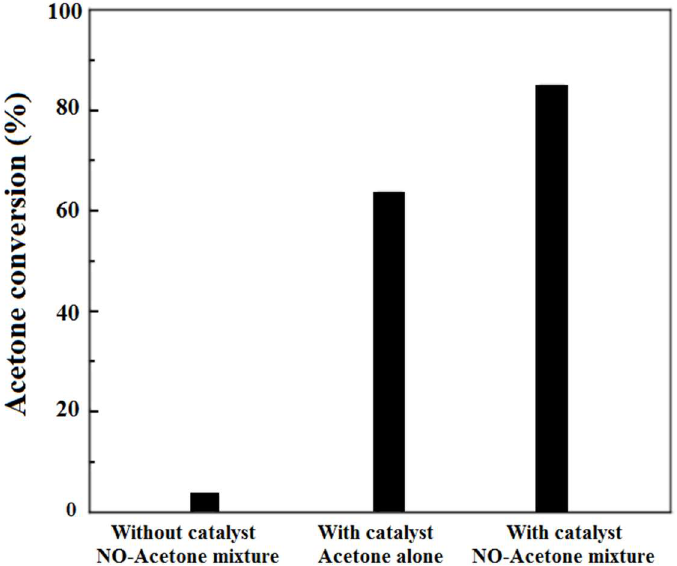
Figure 3. Influences of NO and catalyst (Cu-Al-MCM-41 (50)) on conversion of acetone. GHSV = 8500 h −1 , [Acetone] = 5000 ppm, [NO] = 500 ppm, T = 350 °C